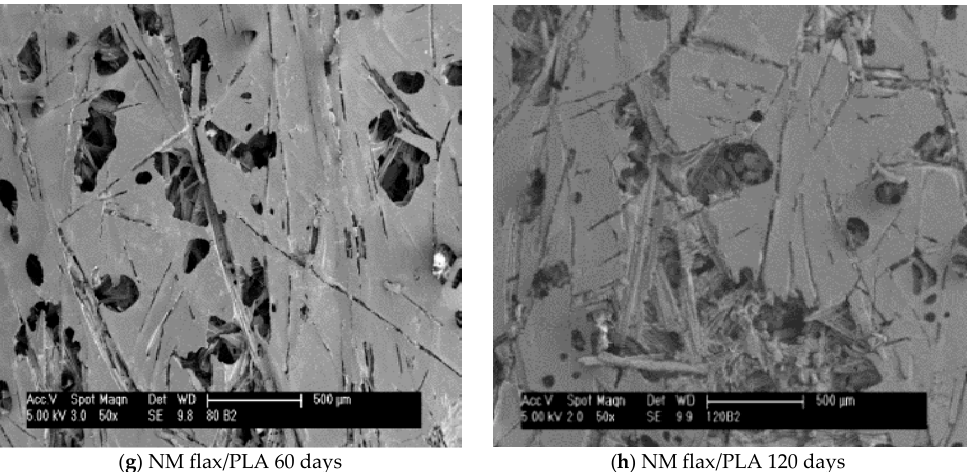
Figure 11. SEM images of biodegradation effect on neat PLA ( a – d ) and NM flax/PLA composites ( e – h ).